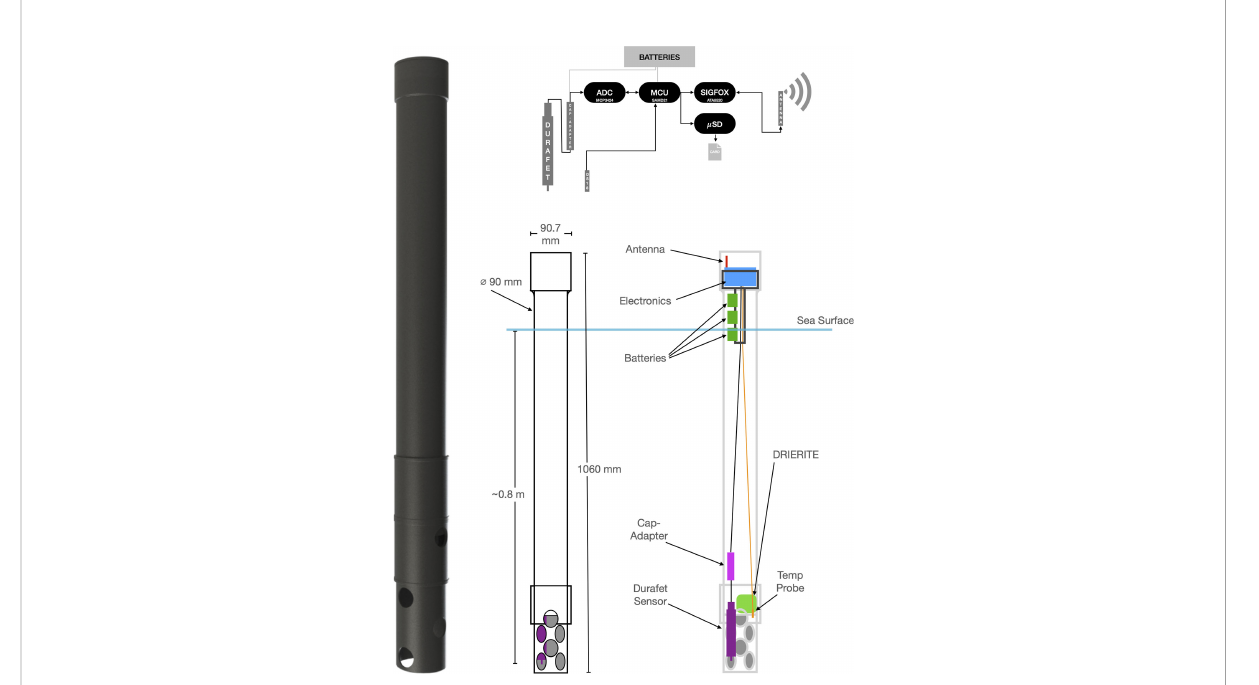
FIGURE 2 Image, layout and dimensions of the SURCOM instrument, case design and location of main components. The upper panel shows the schematic diagram of operation, including involved components and data fl ow